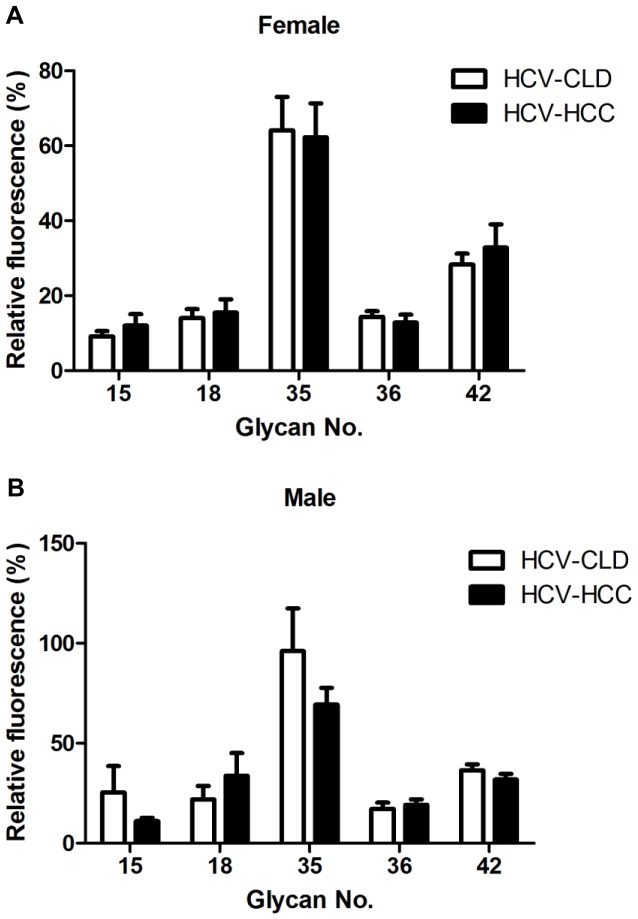
Comparison of the level of select anti-glycan antibodies from HCV-related HCC and CLD by gender.Relative fluorescence ratios were calculated as the fluorescence intensity for each glycan analog divided by the fluorescence intensity for Gb5, and they are expressed as percentages in the figures. The figure shows the mean ratio ± standard deviation for each glycan. The ratios for glycan numbers 15, 18, 35, 36 and 42 were no significant difference between HCV-related HCC and CLD (HCV) in females (n = 18 and 61, separately) (A) and males (n = 47 and 73, separately) (B). (P>0.05).